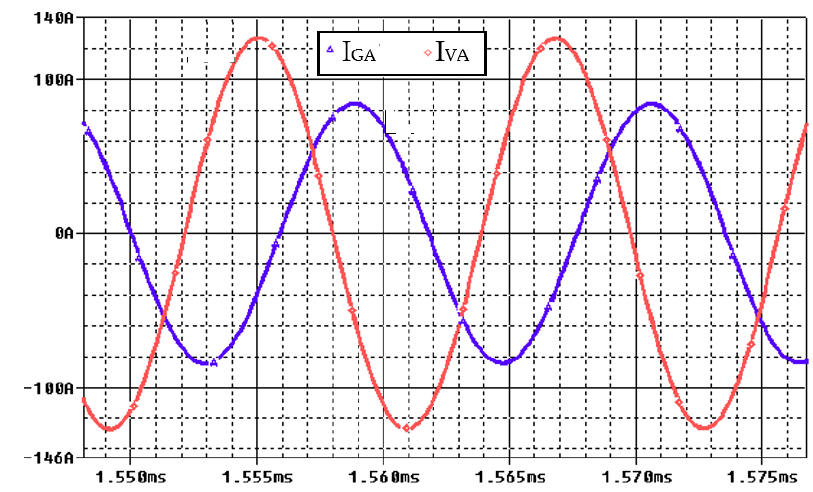
Figure 15. Waveforms of the coil currents for LCC compensation.